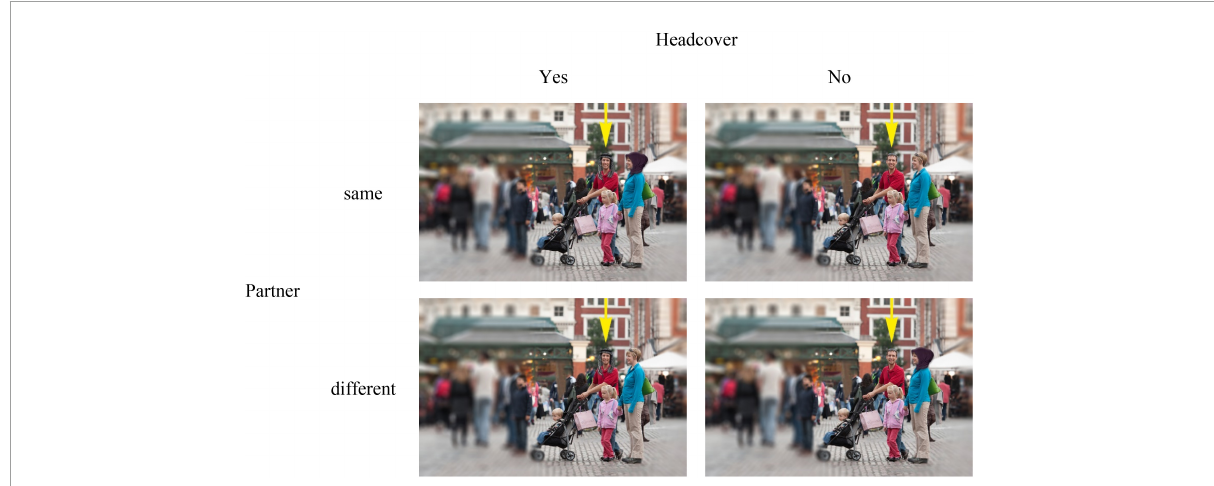
FIGURE6 Stimuli used in experiment 2. The figure shows all variations for the male target person. For the female target person, the arrow was moved above the female. To ensure the anonymity of the people displayed in the photograph, faces were blurred for the published manuscript. The original photo (without head cover and blurring effects) was kindly made public by Jason Pier through CC BY-NC 2.0